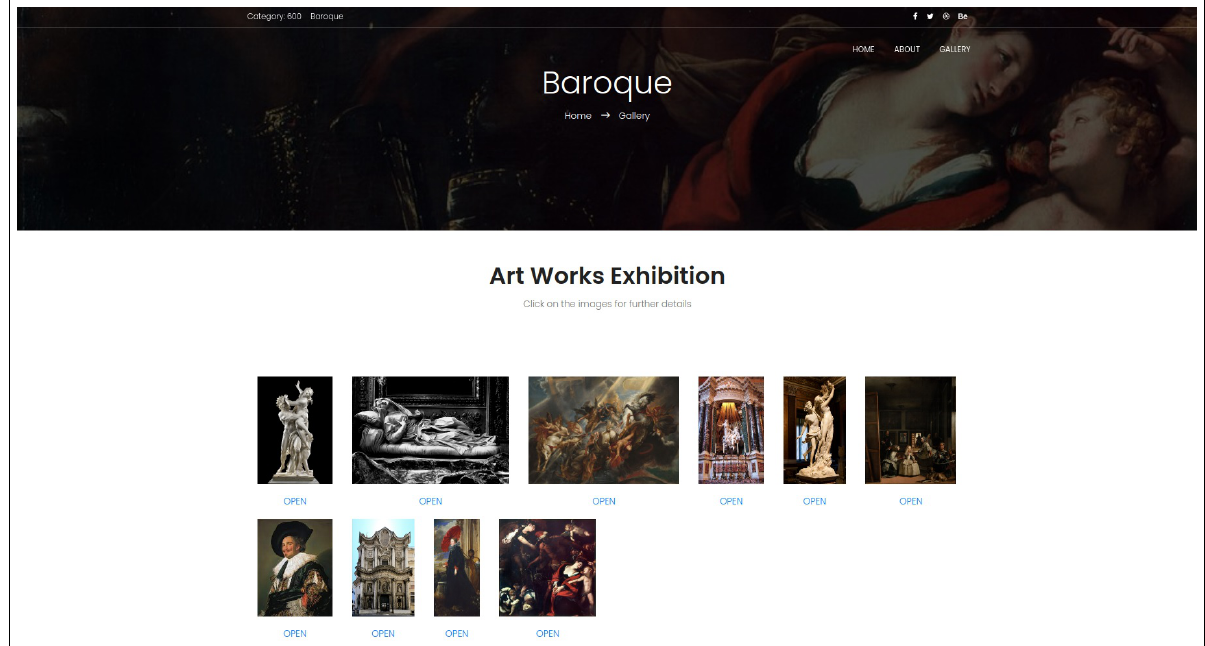
Figure 4. A thematic tour is a collection of artworks of the same artistic period (i.e., Baroque). By clicking on OPEN , it is possible to access a more detailed description of the artwork